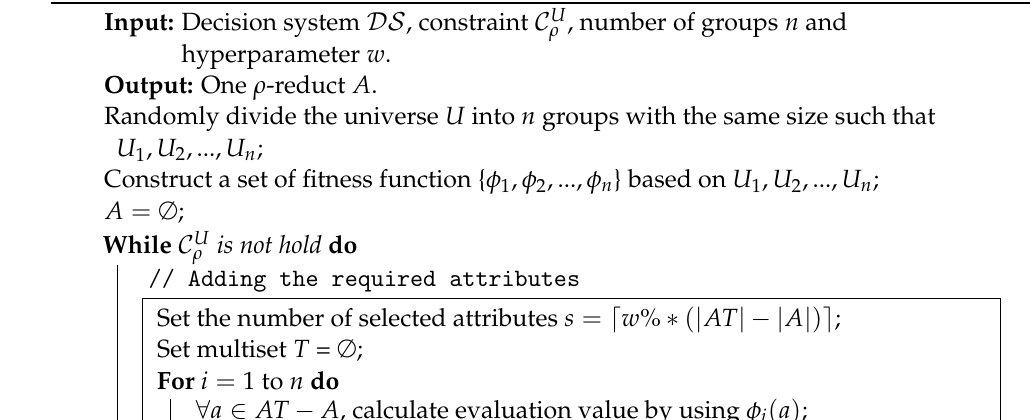
Algorithm 3: Beam-influenced selector-based attribute reduction